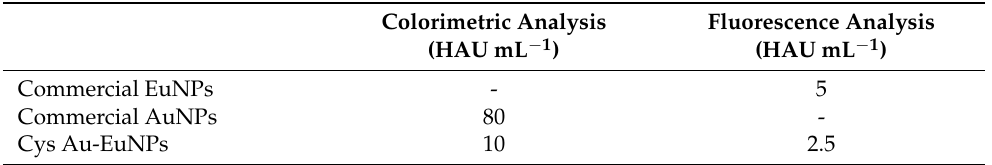
Table 2. Summary results for the LOD of commercial AuNPs, commercial EuNPs, and cysteamine Au-Eu nanocomposites tested in various titers of original H5N1 virus samples with lysis buffer and optimized